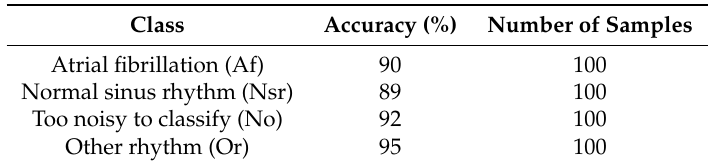
Figure 14. Confusion matrix of merge process. Table 3. Accuracy for each class in merge process. Samples used are the same ECG signals converted into